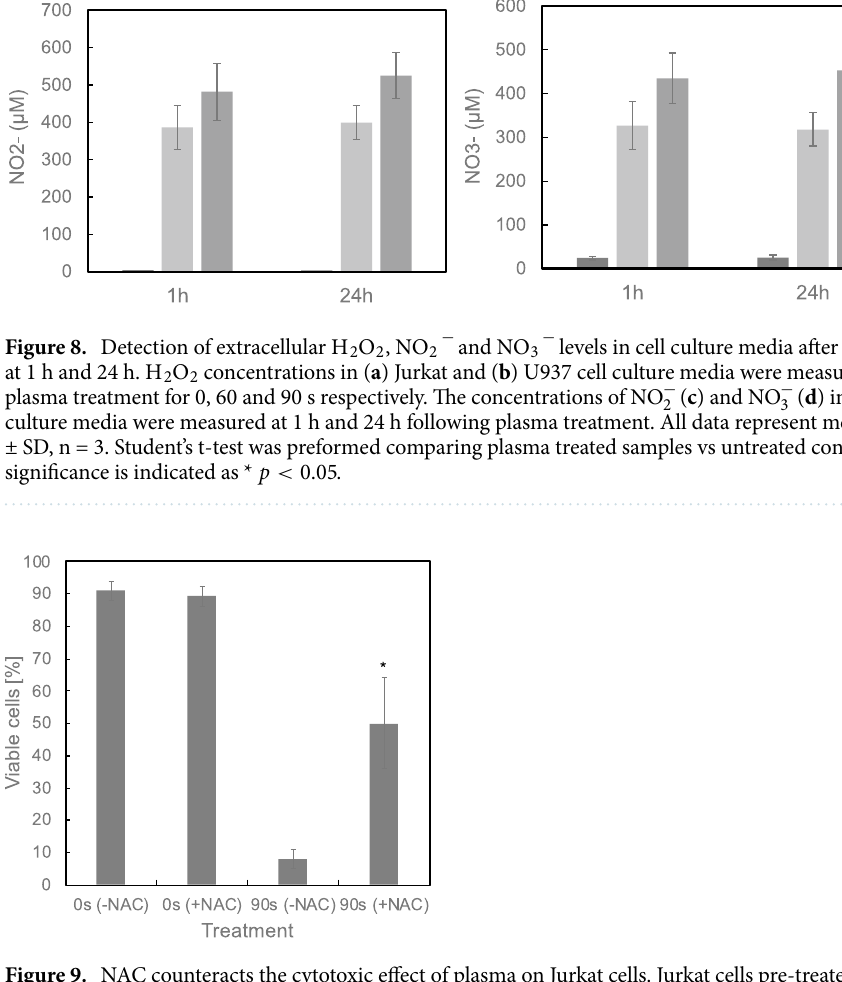
Figure 9. NAC counteracts the cytotoxic effect of plasma on Jurkat cells. Jurkat cells pre-treated with/without − NAC for 1 h, then treated with ns-DBD plasma for 90 s. cell viability were tested 2 h following plasma exposure. Results are presented as the mean ± SD (n = 3). The significance is indicated as * p <